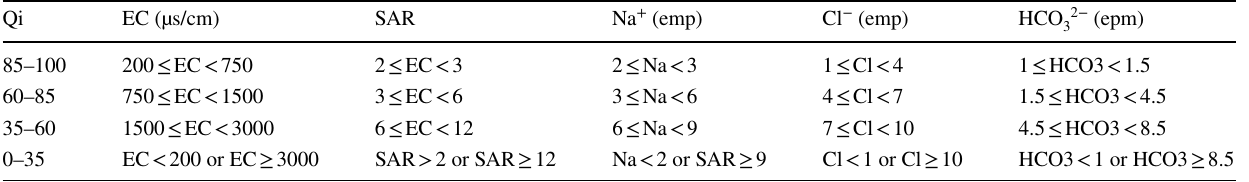
Table 2 Limiting values for parameters in the computation of quality measurement (Qi)